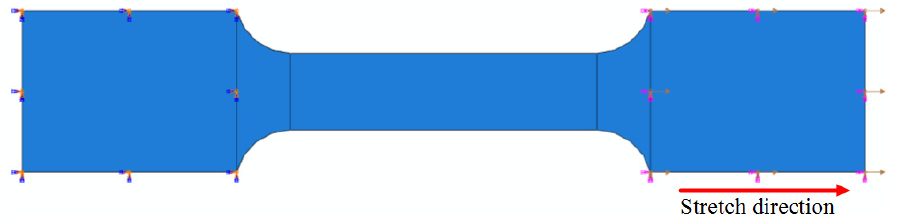
Figure 10. ABAQUS simulation model’s boundary conditions.